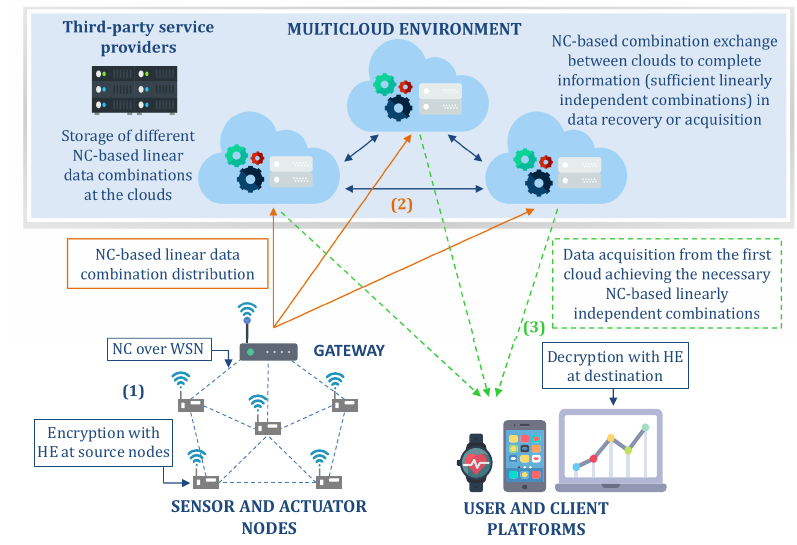
Figure 4. Role of NC and HE over the entire vertical of IoT architectures generally composed of: (1) a WSN; (2) a multi-cloud deployment; and (3)